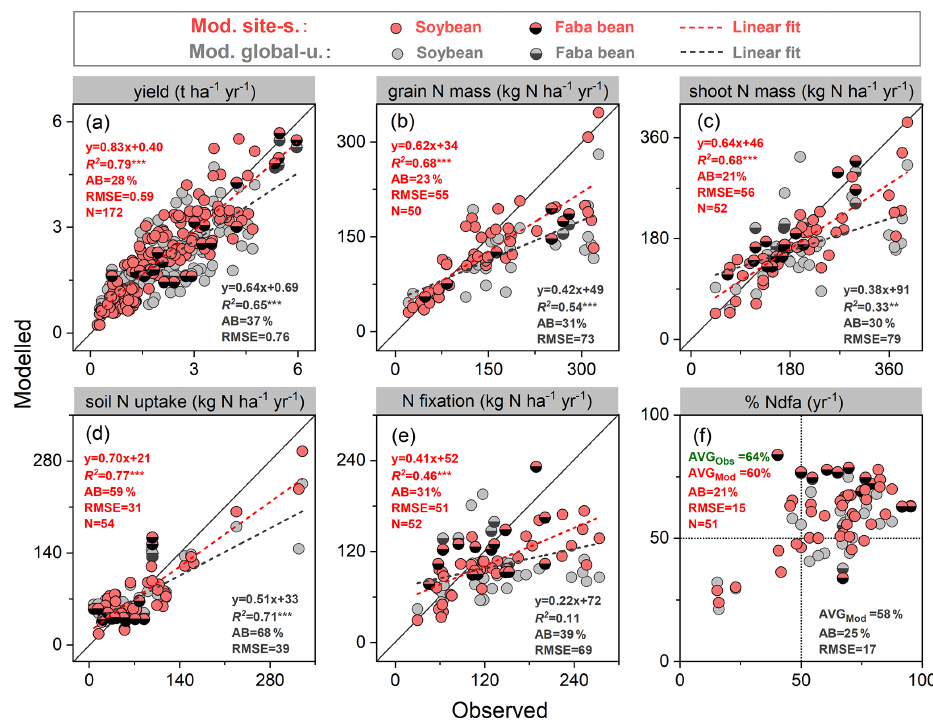
Figure 4. Comparison of modeled and observed yield (a) , grain N mass (b) , shoot N mass (c) , soil N uptake (d) , BNF (e) , and %Ndfa (the proportion of plant N derived from the atmosphere) (f) at harvest across all soybean and faba bean sites. Filled red and grey circles depict the “site-specific” and “global uniform” runs, respectively. The dashed line is a fitted linear regression with red for site-specific and grey for global uniform; ∗∗∗ and ∗∗ denote regressions statistically significant at p = 0 . 001 and 0.01, respectively; AB is absolute bias (Eq. 17), represented in percent (%); the unit of RMSE is the same as the associated variable; AVG in (f) is the averaged value of %Ndfa across all field trials. Table 2. Comparison of modeled and observed yield (tha − 1 ), grain N mass (kgNha − 1 ), shoot N mass (kgNha − 1 ), soil N uptake (kgNha − 1 ), and N fixation rate (kgNha − 1 ) from a soybean nodulation and non-nodulation experiment at harvest. The observed data were compiled using Tables 2–4 in Zapata et al. (1987).